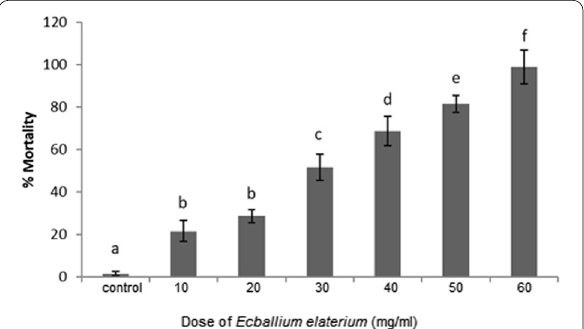
Fig. 1 The percentage of mortalities of E. elaterium fruit juice against larvae of G. mellonella 24 h. *Letters above bars indicate significant differences between concentrations. Bars with the same letter are not significantly different. Error bars indicate SD of means